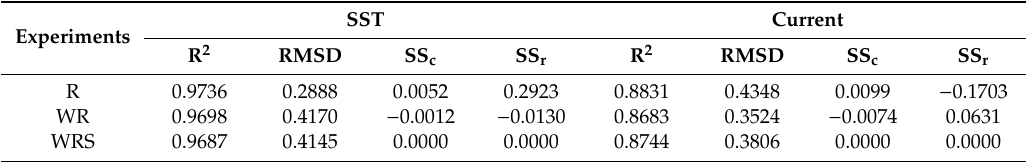
Table 4. Correlation coe ffi cients (R 2 ), root-mean-square errors (RMSD) and skill scores (SS c and SS r ) for SST and ocean surface current from the di ff erent